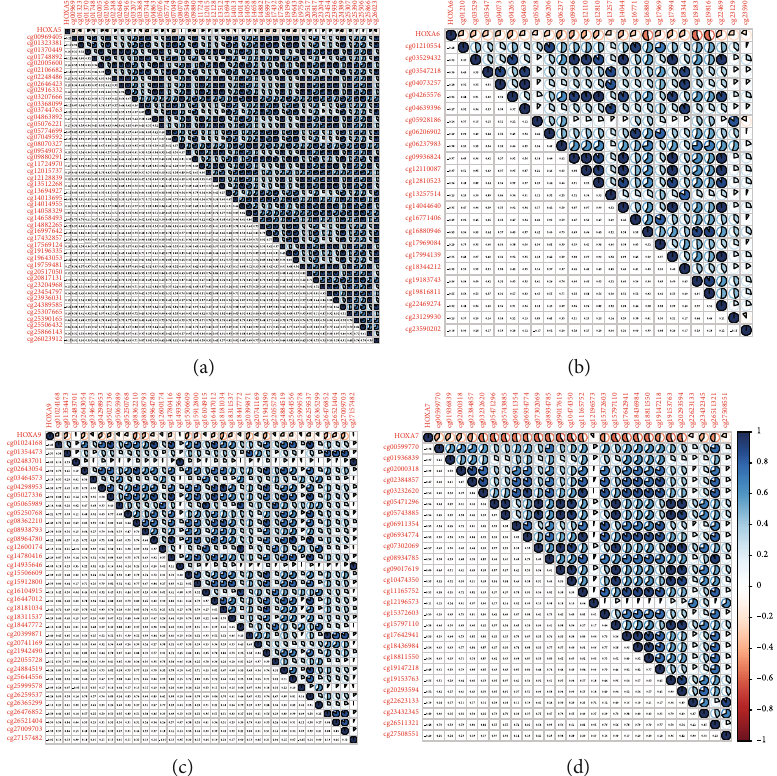
Figure 5: Pearson ’ s correlation between methylation levels and expression of (a) HOXA5, (b) HOXA6, (c) HOXA9, and (d)